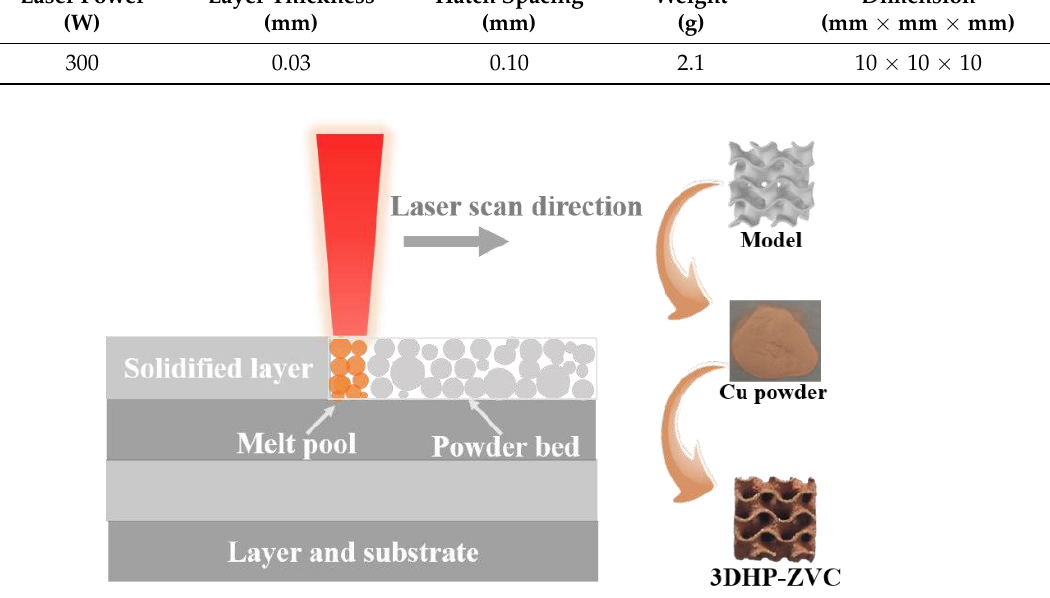
Figure 6. Schematic illustration of printing 3DHP-ZVC through SLM